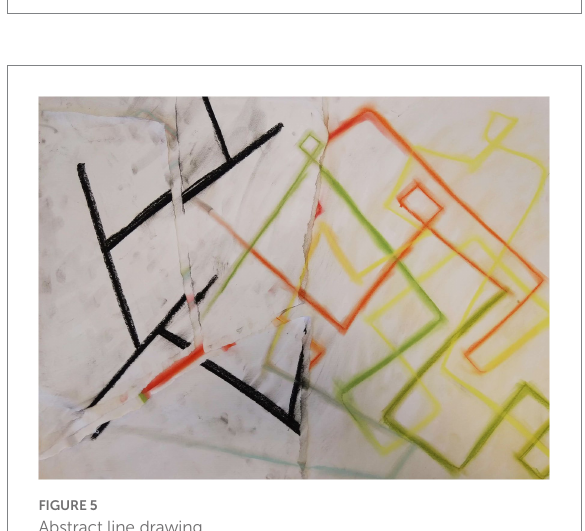
FIGURE 4 Mask inside out.